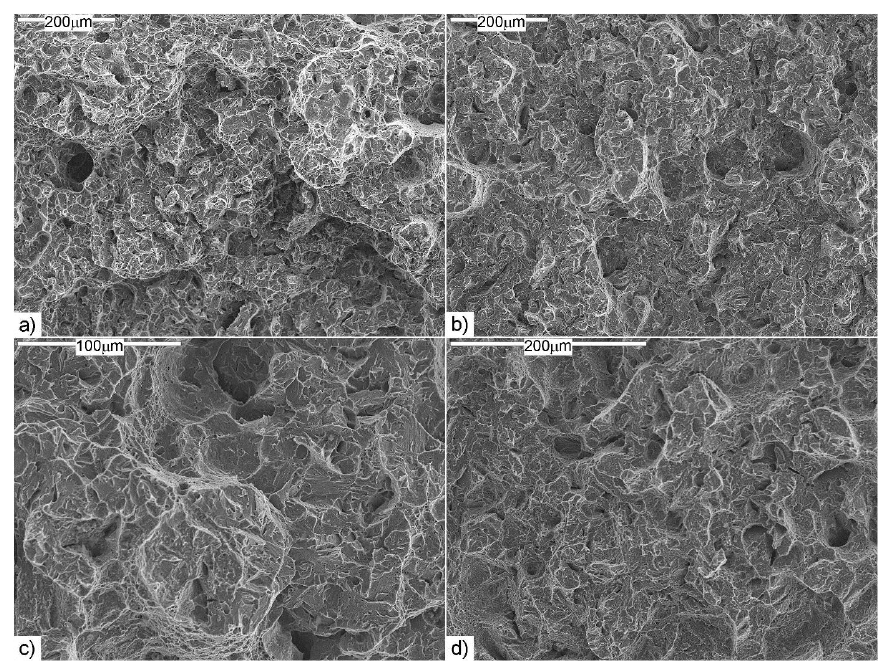
Figure 13. Fracture of the tested sample austenitized at 900 °C: ( a ) the zone under the mechanical notch; ( b ) the quasi-brittle central zone with visible ductile area; ( c ) the central zone with visible “small column”; ( d ) the quasi-cleavable zone with visible transverse cracks, SEM.